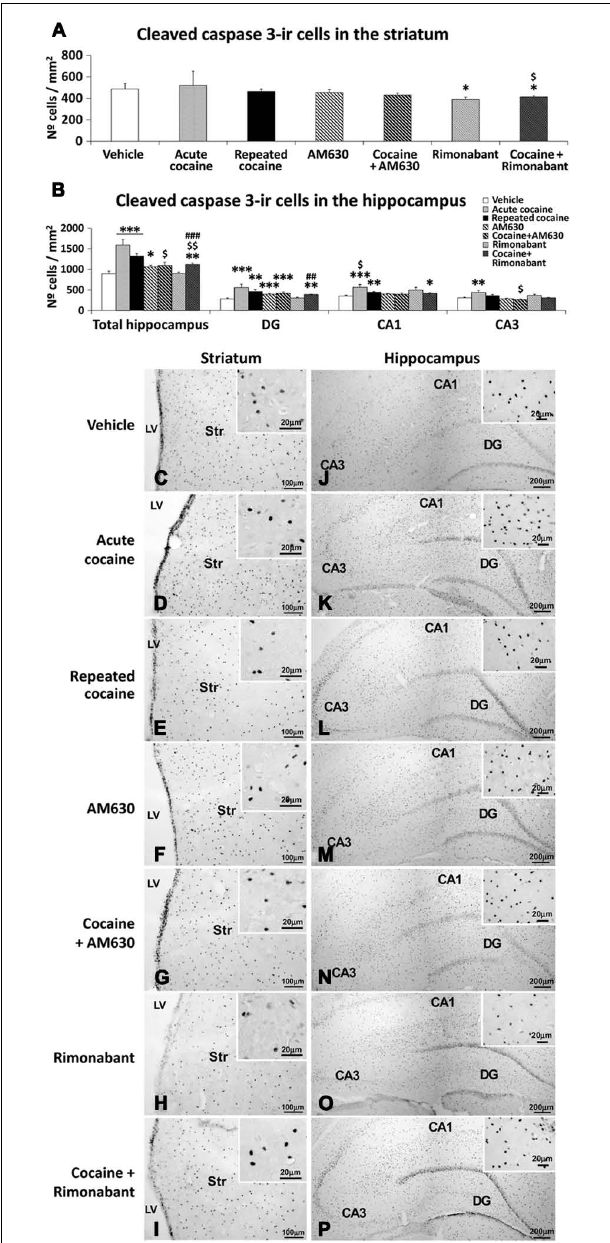
FIGURE 5 | Effects of repeated administration of cocaine and co-administration of cocaine (20 mg/kg) and Rimonabant (3 mg/kg) or AM630 (3 mg/kg) on cell apoptosis in the striatum (A) and hippocampus (B) as measured with cleaved caspase-3 immunohistochemistry. Rimonabant administration decreased the numbers of cleaved caspase 3-ir cells observed in the striata and hippocampi of the repeated cocaine-treated rats. Only AM630 decreased the numbers of cleaved caspase 3-ir cells in the hippocampi of the repeated cocaine-treated rats. (C–P) Representative microphotographs showing low- and high-magnification (insets) views of apoptotic cells in the striatum and hippocampus.The histogram displays the means ± SEMs ( n = 8/group) of the numbers of cleaved caspase 3-ir cells per area (mm 2 ). One-way ANOVA: ∗ P < 0.05, ∗∗ P < 0.01, ∗∗∗ P < 0.001 vs. vehicle group; $ P < 0.05, $$ P < 0.01 vs. repeated cocaine group; ## P < 0.01, ### P < 0.001 vs. Rimonabant group. Scale bars are included in each